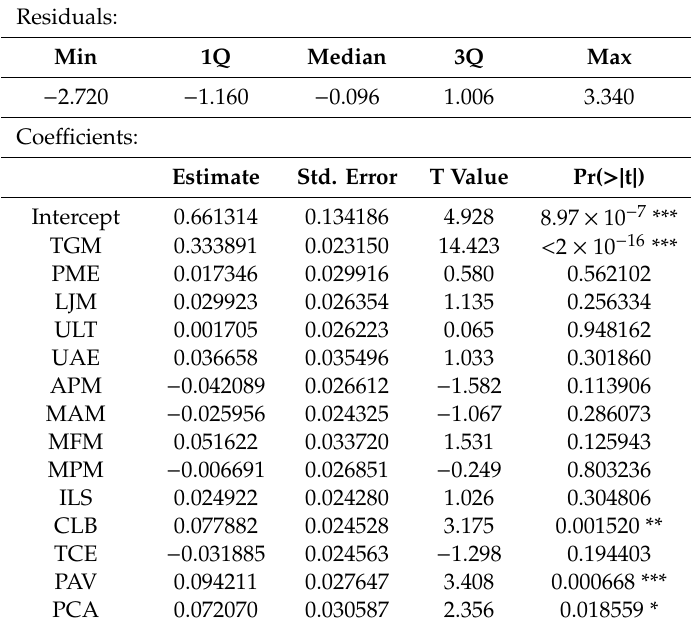
Table 2. Adjustment of the linear regression